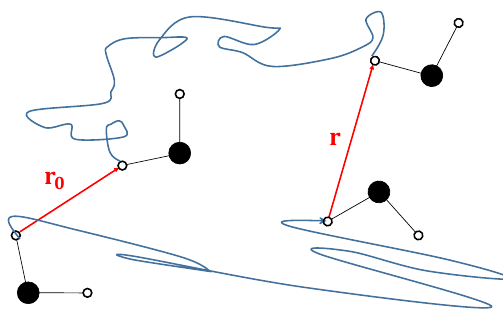
Figure 1. The figure shows, at left, two water molecules at time t = 0. A pair of intermolecular hydrogen spins are connected by a vector r 0 . The molecules diffuse within the porous material and the same two hydrogen atoms are separated by vector r after a time t . The frequency-dependent relaxation rate R 1 ( f ) is determined by the probability density function describing the probability that a pair of spins are separated by r 0 at t = 0 and by r at time t